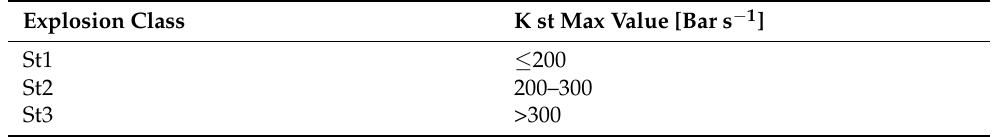
Table 1. Dust explosion classes. Copyright European Standards, 2011.